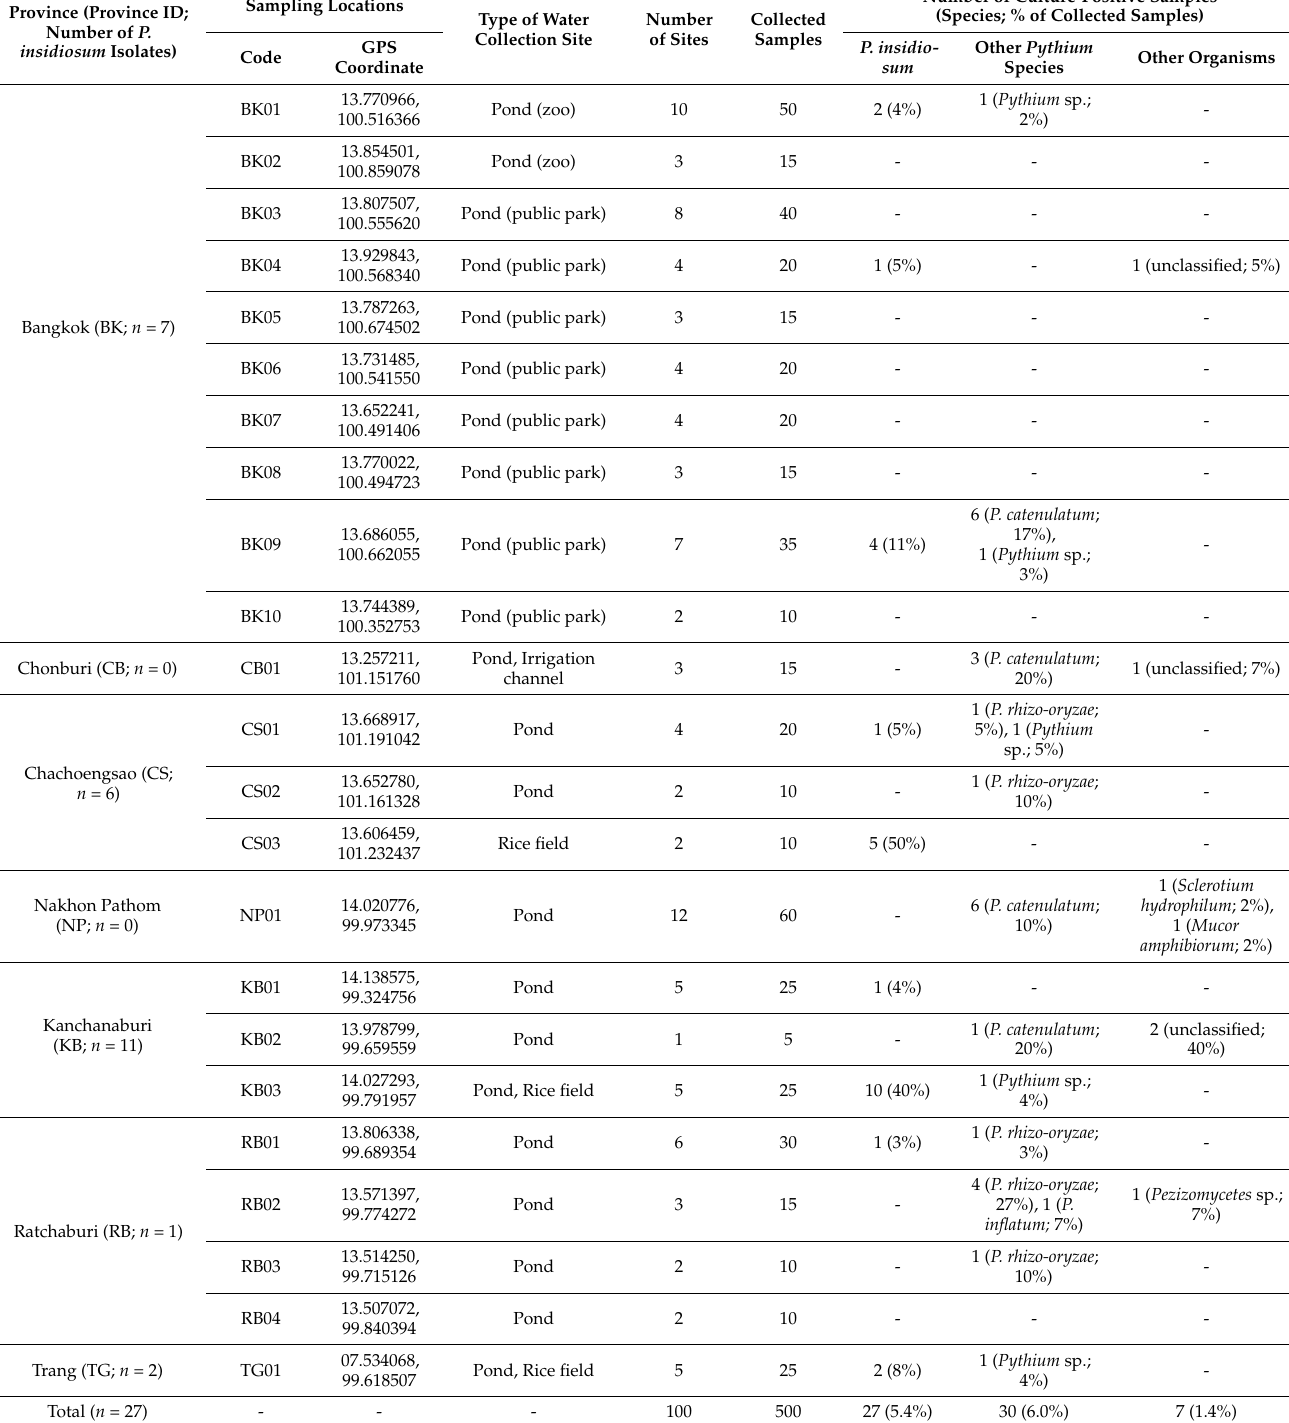
Table 1. Water sampling locations in central and southern Thailand. The global positioning system (GPS) coordinates, type of water collection sites, number of sites and water samples, and identified organisms are shown in the table. Province (Province ID; Number of